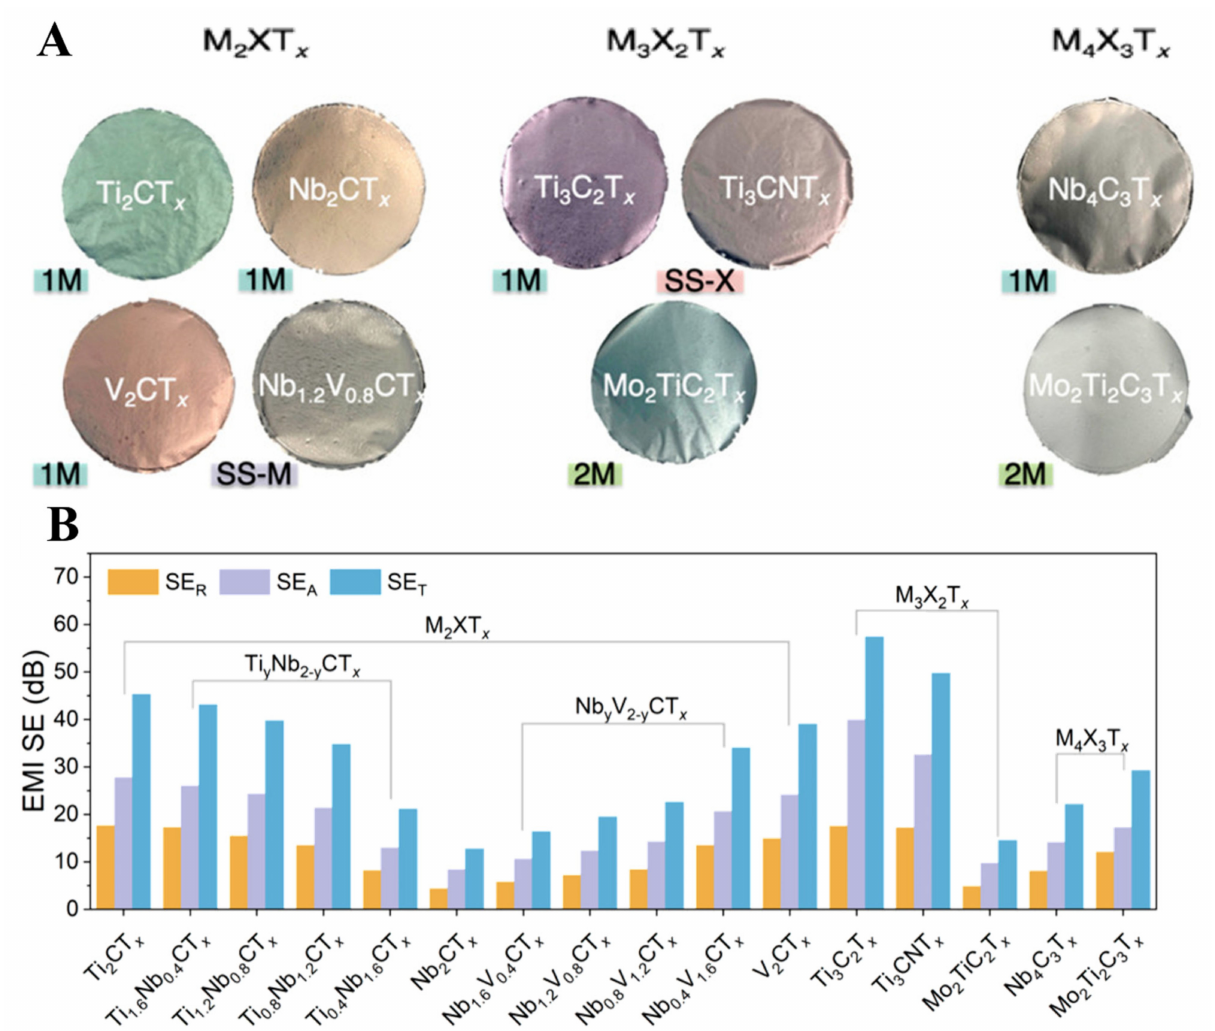
Figure 11. ( A ) Digital images of mono-transition metal MXenes (1M), double-transition metal MXenes (2M), Solid solution on M sites (SS-M), Solid solution on X sites (SS-X) by utilizing VFM, and ( B ) The average EMI shielding reflection, absorbance, and transmittance (SE R , SE A , and SE T ) of variety of MXene thin films with thickness range from 5 ± 0.3 µ m in the 8.2–12.4 GHz range (reproduced with permission [149], Copyright 2020, American Chemical